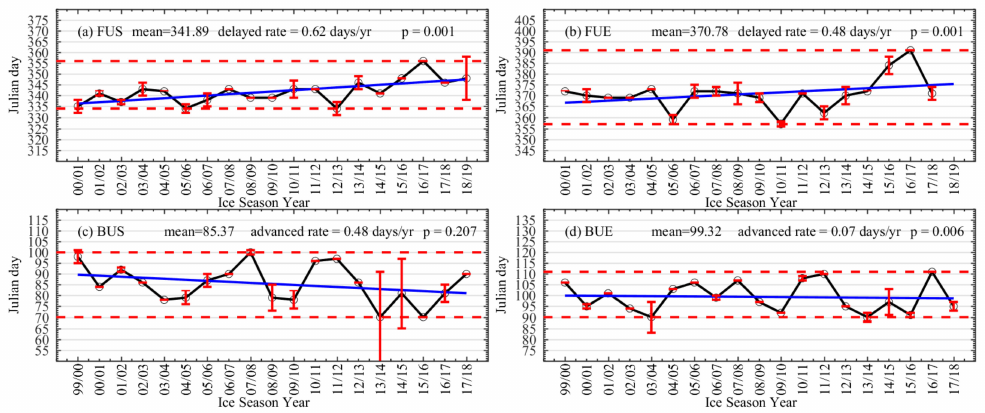
Figure A2. The availability of critical dates of FUS, FUE, BUS and BUE, mean values, and delayed / advanced rates (red dotted lines represent the value ranging from the minimum value to the maximum value, red bar represent the error of each